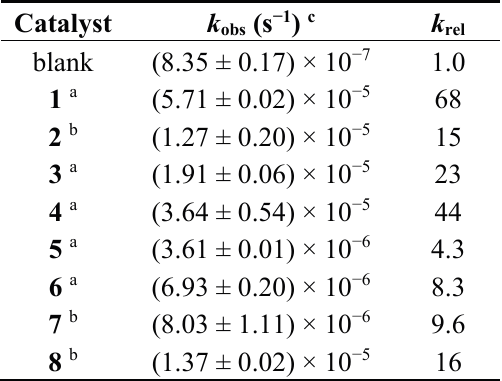
Table 1. Pseudo first-order rate constants ( k obs ) and relative rates ( k rel ) for bromination of 4-pentenoic acid ( 19 ) with TEOS xerogel-sequestered catalysts/catalyst precursors 1 – 8 compared to a catalyst-free TEOS xerogel control in pH 6.2 phosphate buffer a